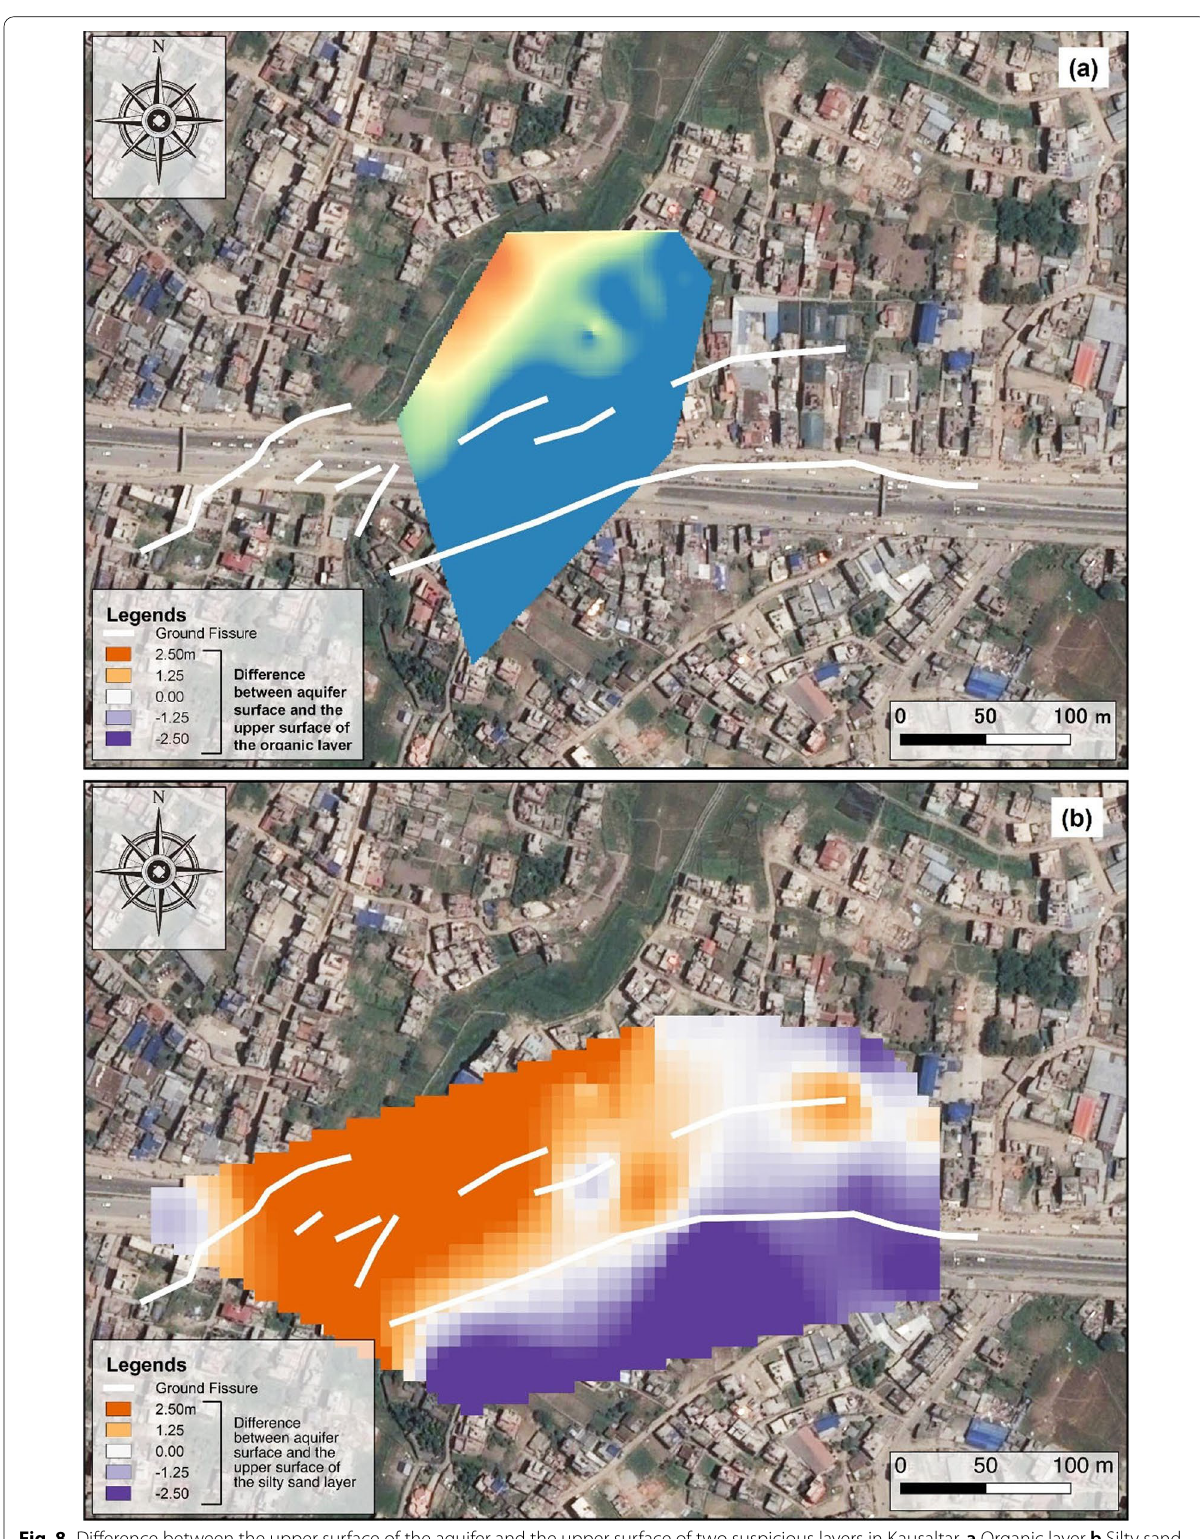
Fig. 8 Difference between the upper surface of the aquifer and the upper surface of two suspicious layers in Kausaltar. a Organic layer b Silty sand